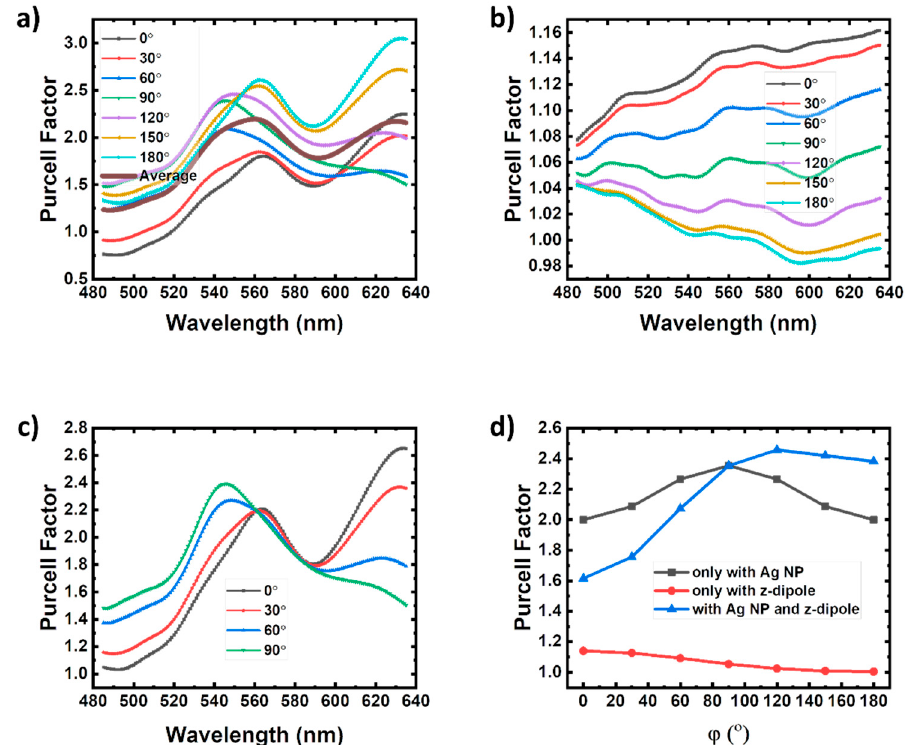
Figure 5. Purcell factors of the q-dipole: ( a ) with both the Ag nanoparticle (NP) and z-dipole, ( b ) only with the z-dipole and ( c ) only with the Ag NP. The z-dipole and q-dipole are placed at Point B and B’, respectively. ( d ) The dependence of the Purcell factors of the q-dipole at 551 nm on di ff erent polarized angles ϕ only with the Ag NP, only with the z-dipole and with both the Ag NP and z- dipole.